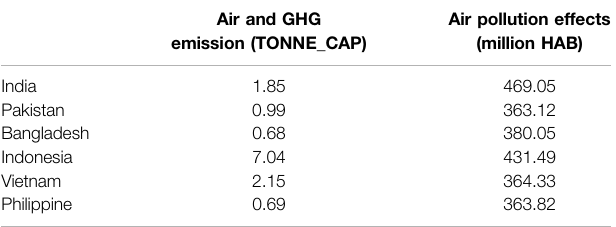
TABLE 2 | Scores of negative indicators in South-East Asia.